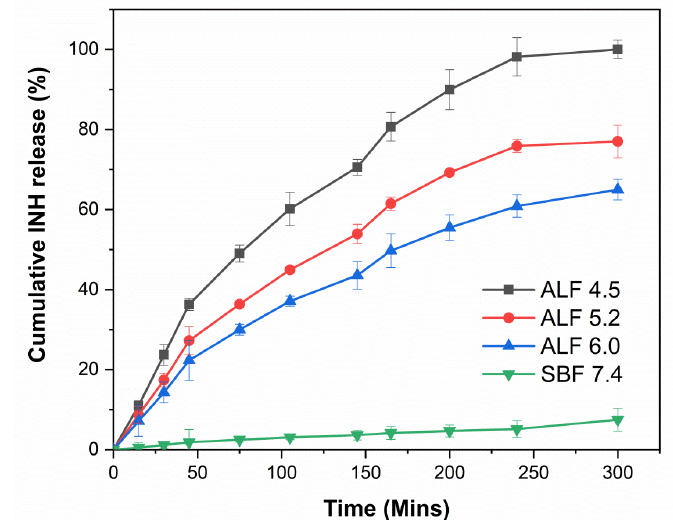
Figure 5. The release of INH from the synthesized conjugate in artificial lysosomal fluid (ALF) media at different pH 4.5, 5.2, 6.0 and simulated body fluid (SBF) 7.4.